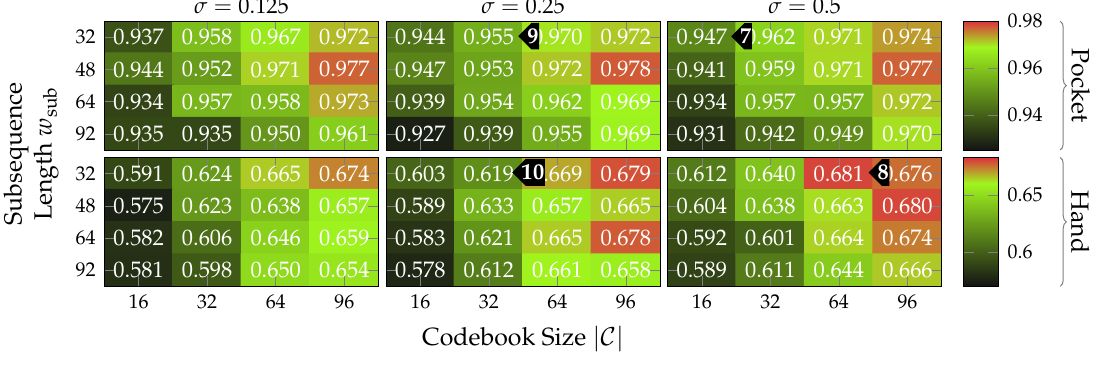
Figure 17. Classification accuracies achieved with the approach based on codebooks for multiple different combinations of the σ , w sub , and |C| hyperparameters for both pocket-case and